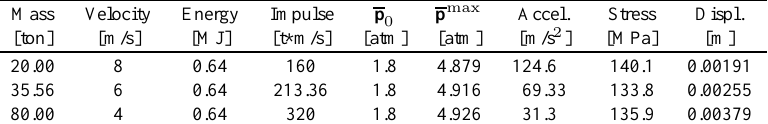
Table 4 Response of the structure to slow and fast impact of the same